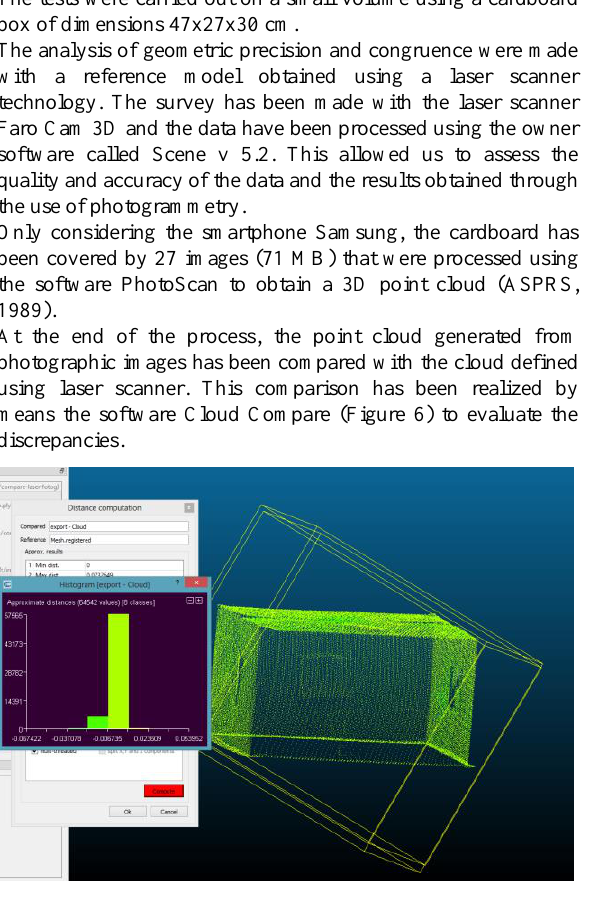
Figure 6. 3D point clouds Comparison